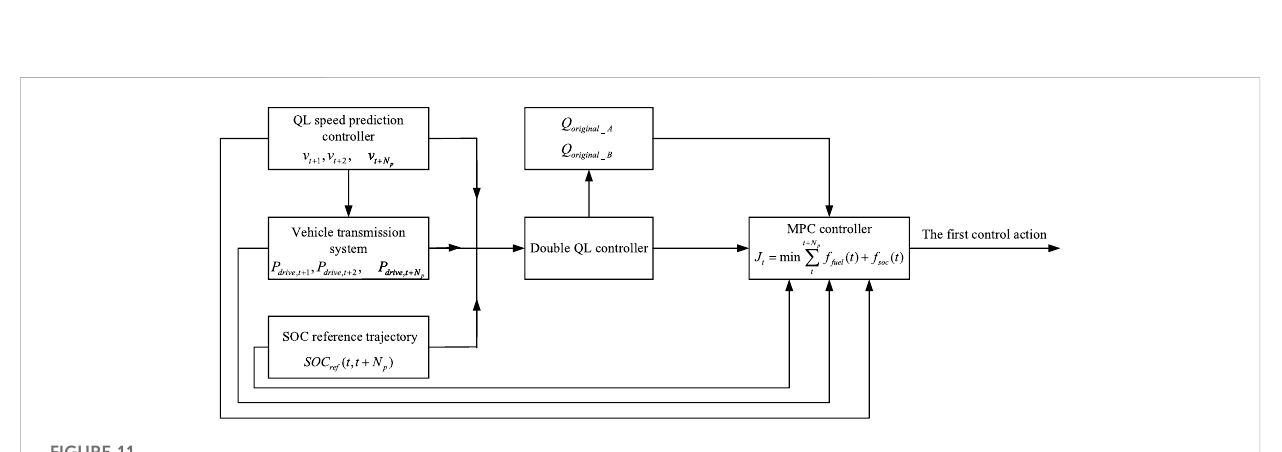
FIGURE 11 Principle of MPC rolling